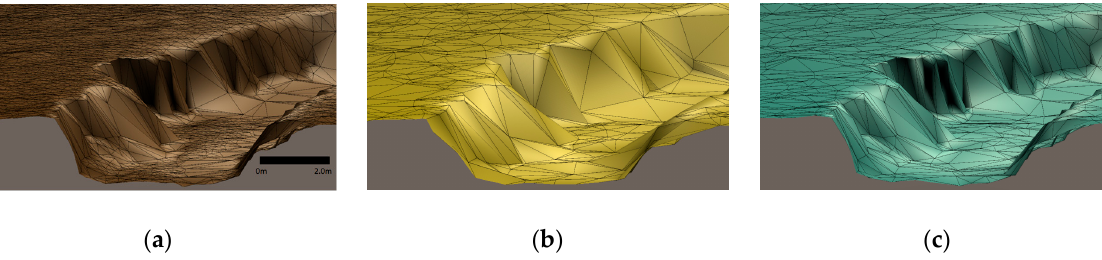
Figure 8. Oblique-perspective view of a detail of the Tuttle Lidar panel showing Celia Creek and the adjacent flood plane. ( a ) is the TIN model of the undecimated Lidar. ( b ) is the TIN model after Random Decimation to 15% of the original point count. ( c ) is the TIN model after Curvature Weighted Decimation to 15% of the original point count.